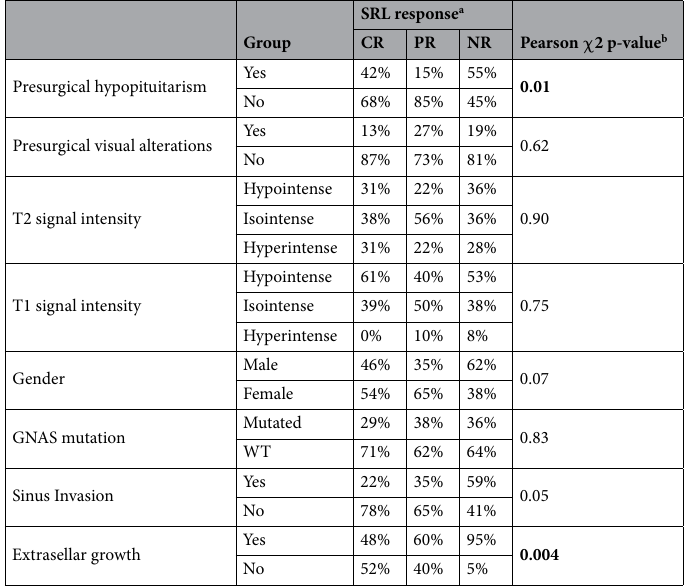
Table 2. Clinical categorical variables related to SRL response. a SRL response columns indicate the percentage of patients with CR, PR, or NR dictated by the presence of absence of the clinical condition. b Pearson χ 2 p-values are shown. Statistically significant values (p-value < 0.05) are reported in bold.